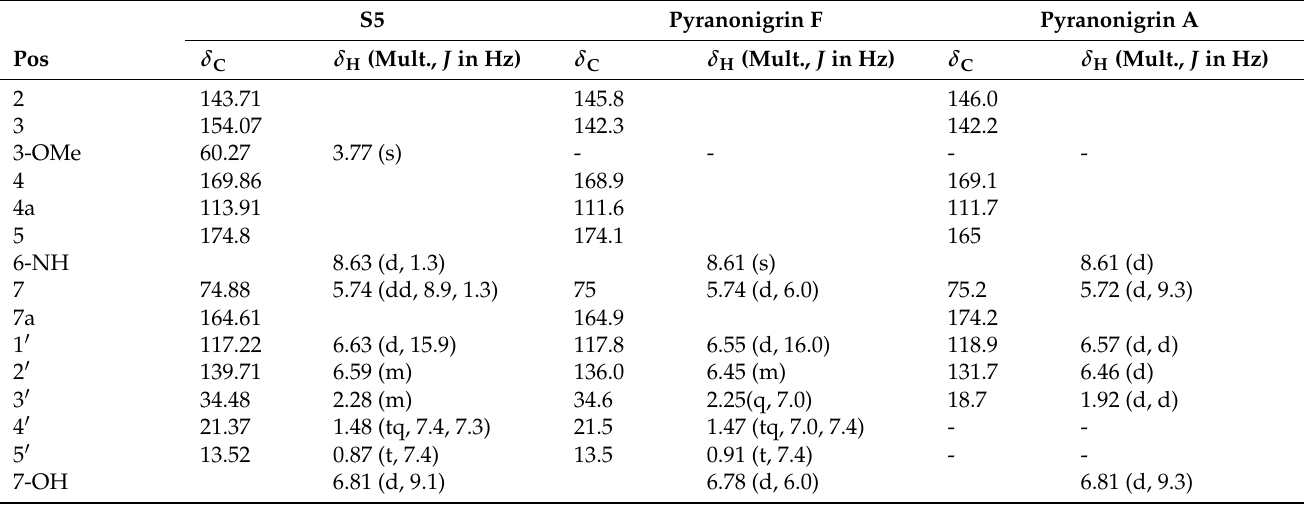
Table 2. 1 H and 13 C NMR analysis of pyranonigrin G ( S5 ), pyranonigrin F and A.